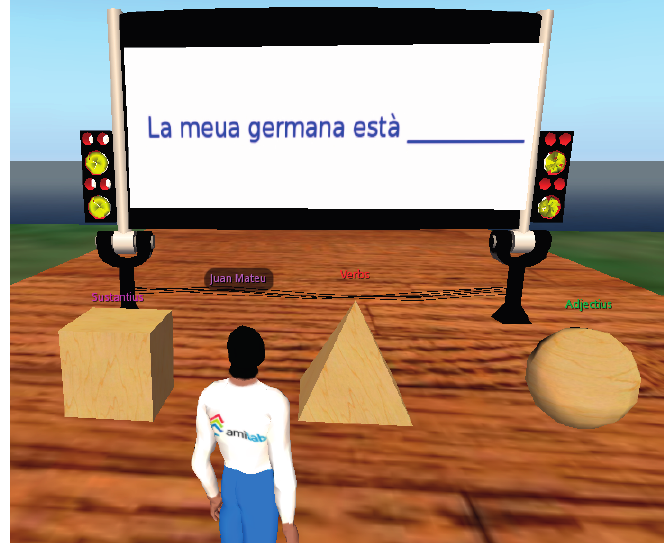
Figure 10. Example of exercise using the tangible